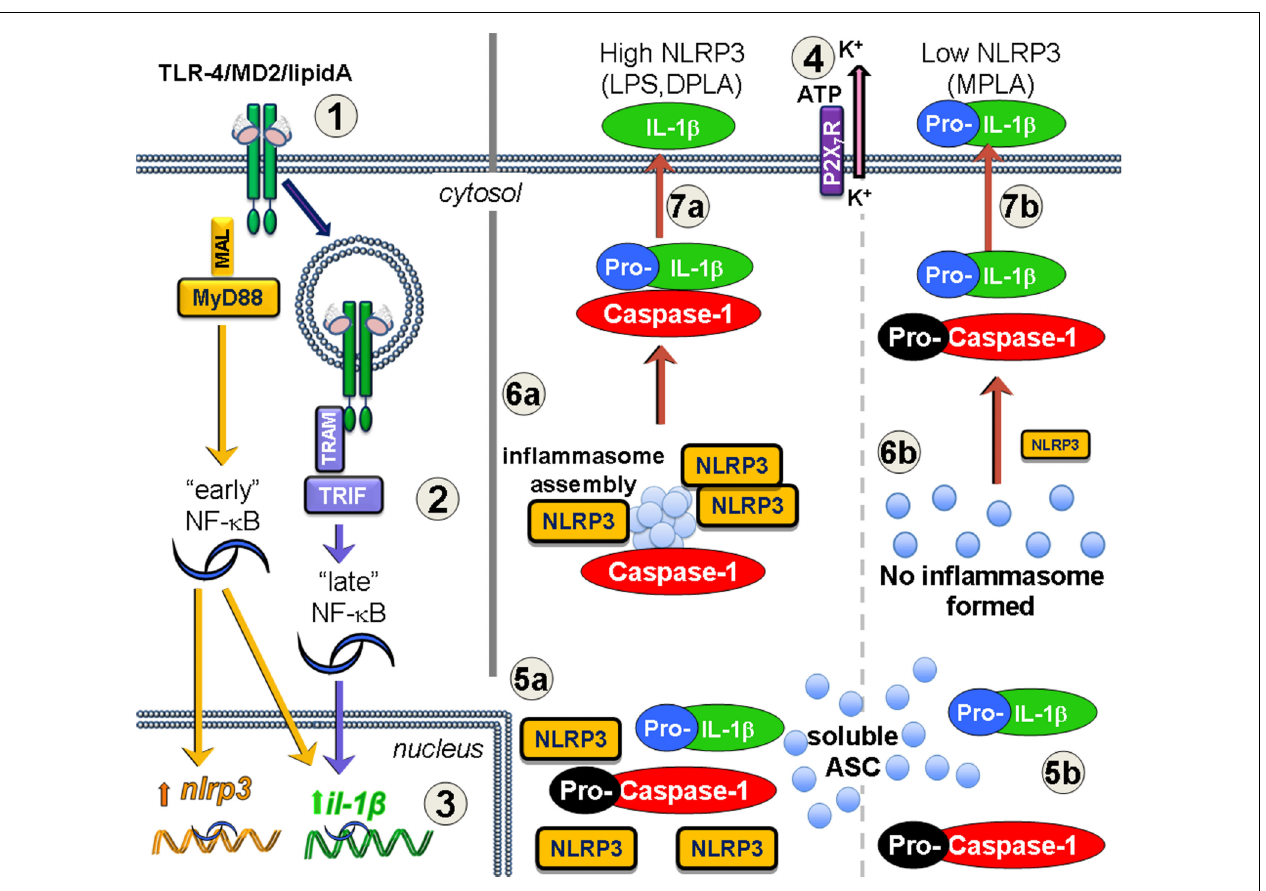
FIGURE 1 | Increased NLRP3 expression via MyD88 leads to inflammasome formation and processing of IL-1 β after lipidA treatment. Priming (1–3) and activation (4–7) are required for mature IL-1 β secretion. (1) TLR4/MD2 binds lipid A forming endotoxin receptor dimers that signal through either MyD88 orTRIF, or both (2) to activate NF- κ B.The MyD88-dependent “early” phase of NF- κ B activity results in increased transcription of both nlrp3 and il1b genes.TRIF-dependentTLR4 signaling occurs after receptor-mediated endocytosis ofTLR4 leading to the “late” phase of NF- κ B activity, and increases il1b gene expression, but not nlrp3 . Inflammasome activation occurs in response to such agonists as